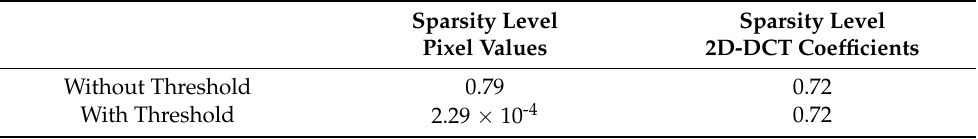
Table 1. STIS spectroscopic data: sparsity level in the original and transform domains (scale is between 0 and 1).